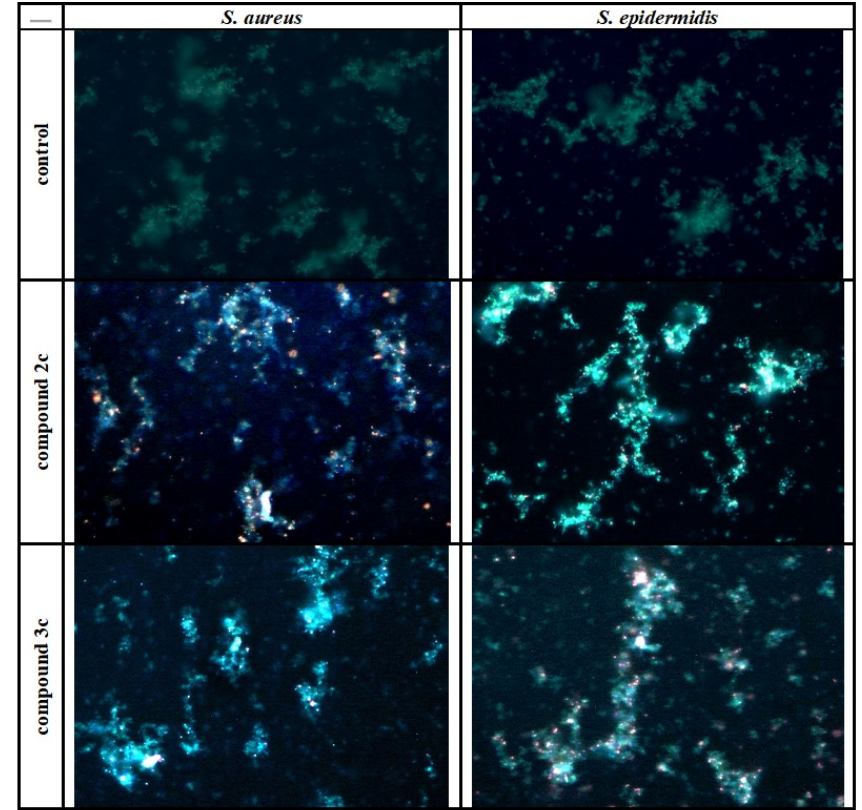
Figure 3. Analysis of the physiological state of bacterial cells stained with two fluorescent dyes: Hoechst 33258 and propidium iodide. Because of different bacterial cell membrane permeability, living cells express pale blue fluorescence, while dead cells express bright blue and red fluorescence.